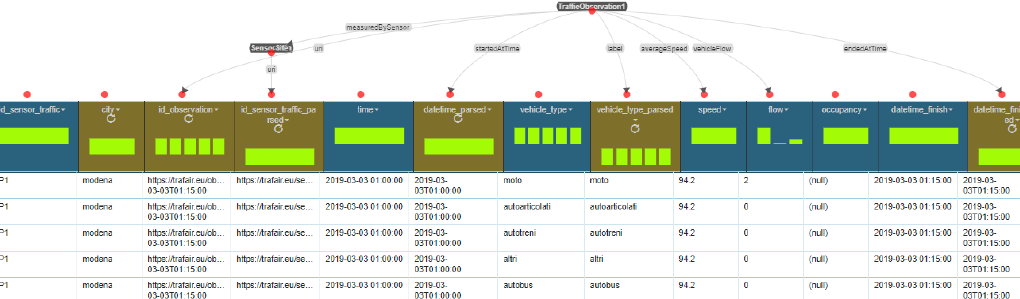
Figure 7. Karma model implemented to transform data from the “sensor_traffic” table (Figure 3) into Linked Data.